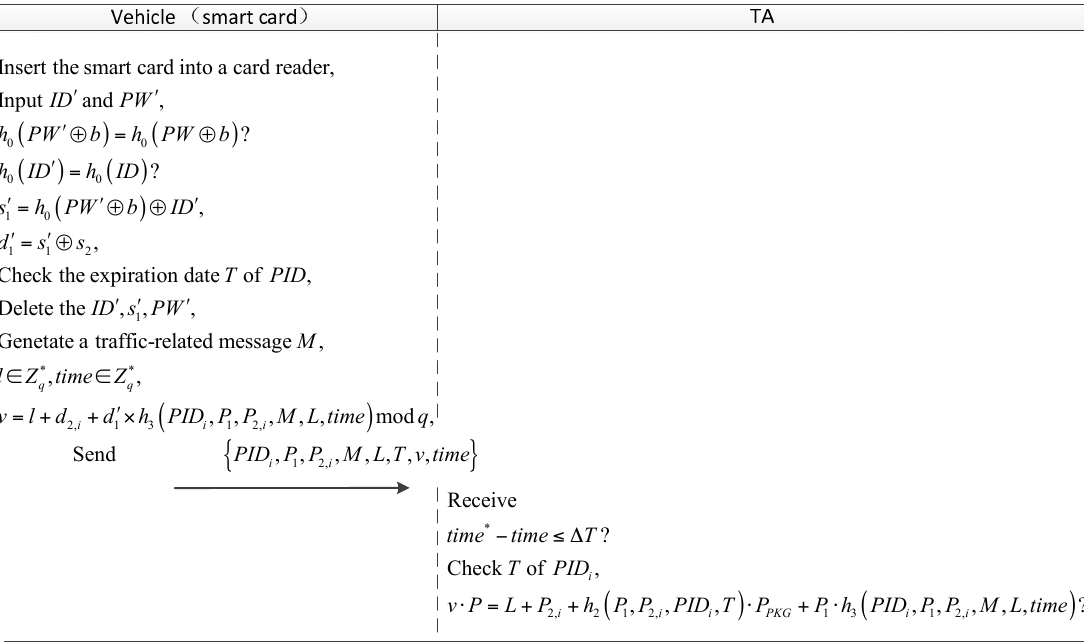
Figure 4. The vehicle to RSU (vehicle) authentication process.